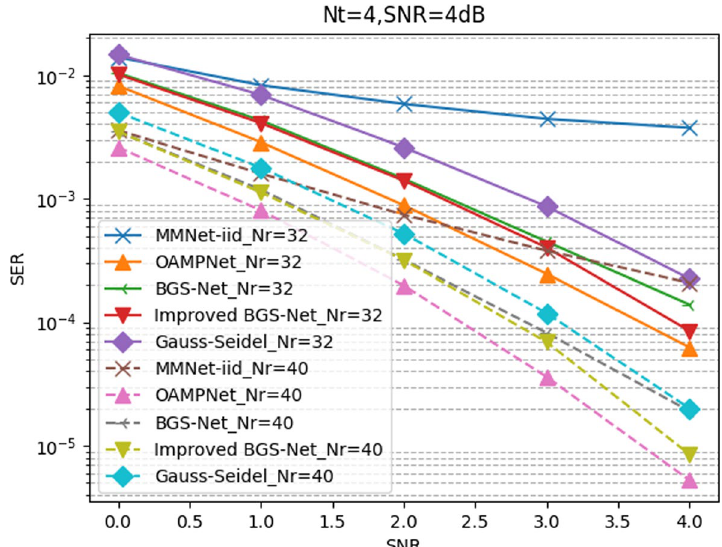
algorithm for N t = 4 , SNR